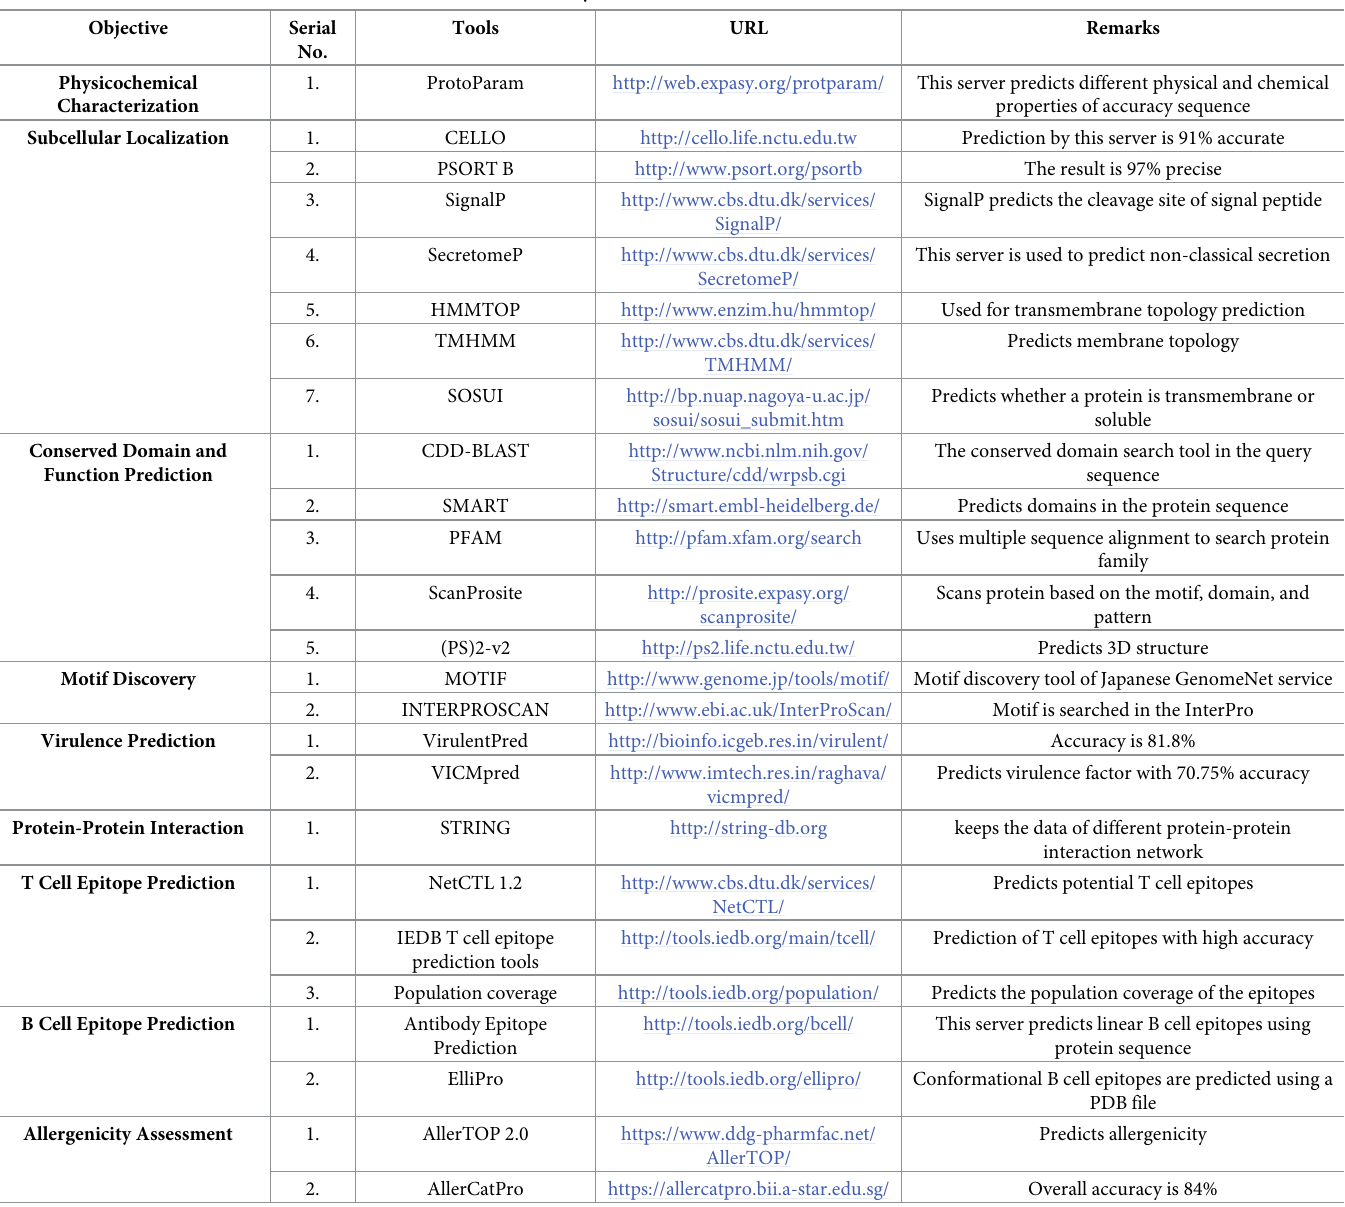
Table 1. List of the bioinformatics databases and tools used in this study. Objective Serial